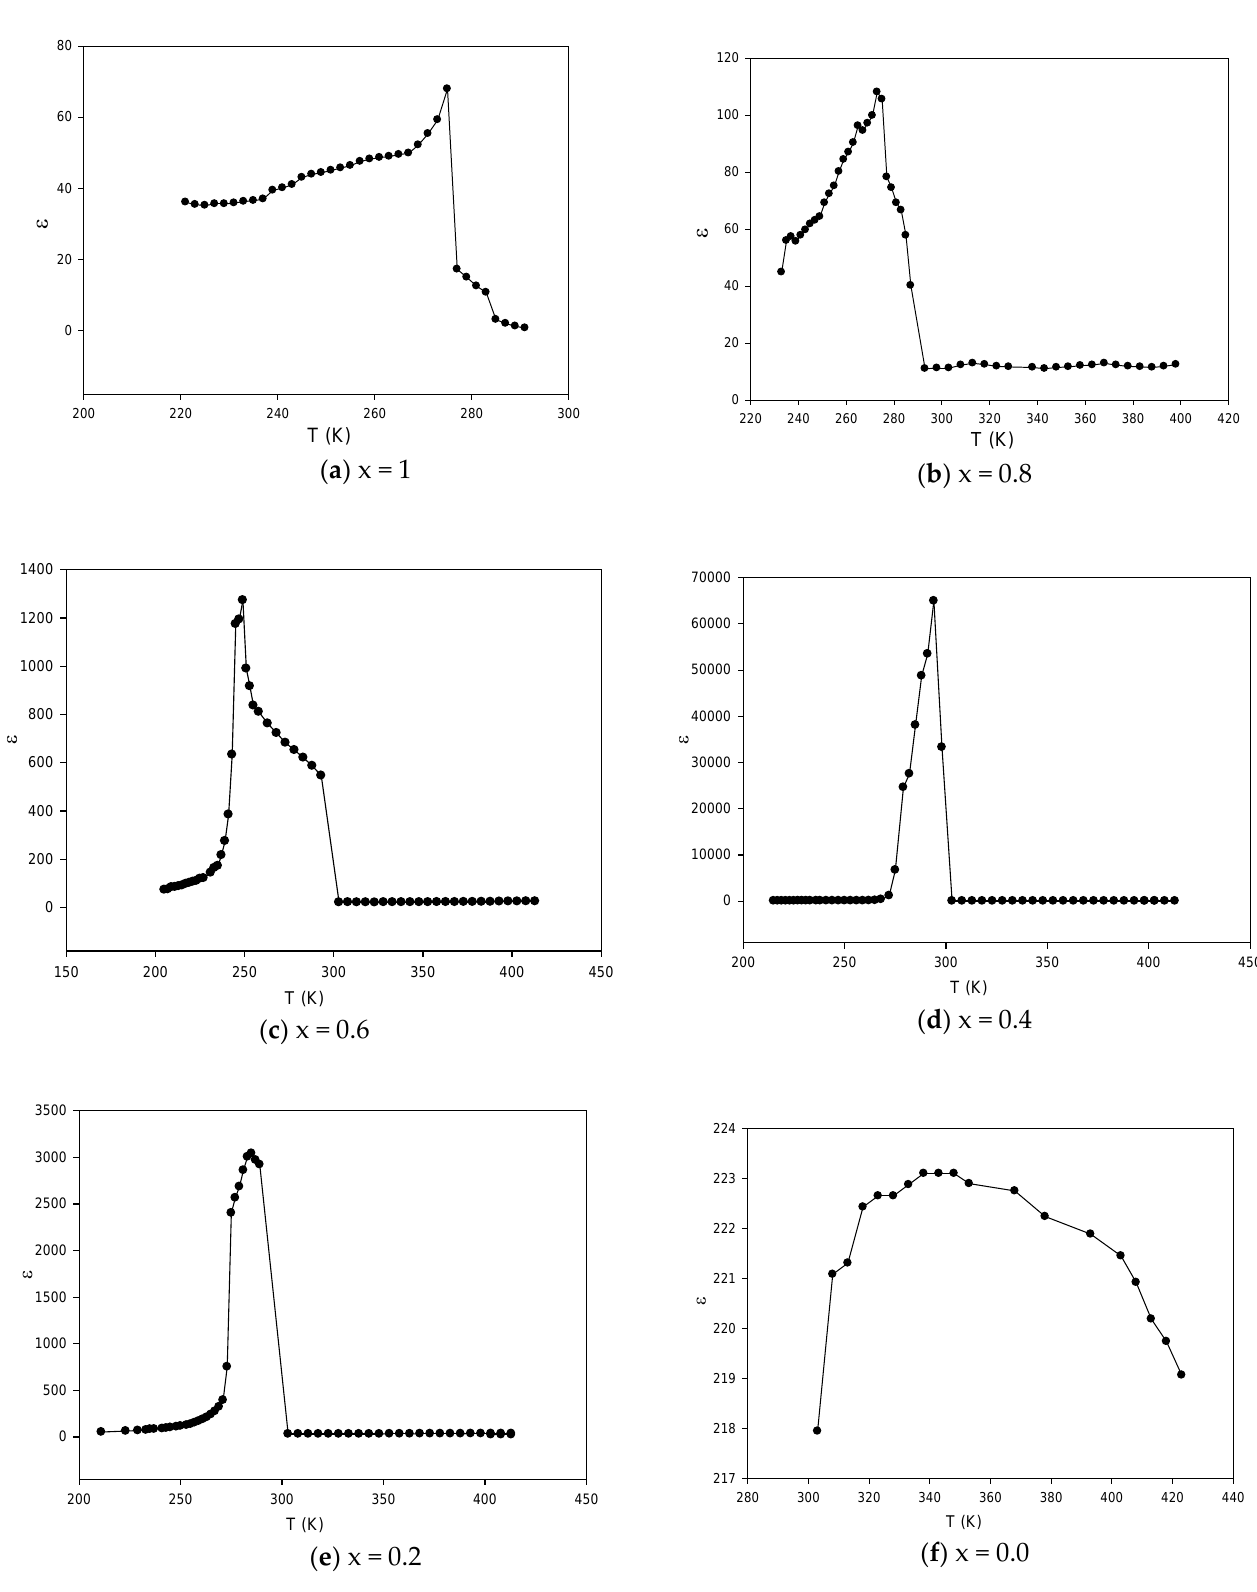
Figure 5. ( a – f ): The effect of temperature on the dielectric constant of (PVDF-BZT) and their composites at 1 KHz.